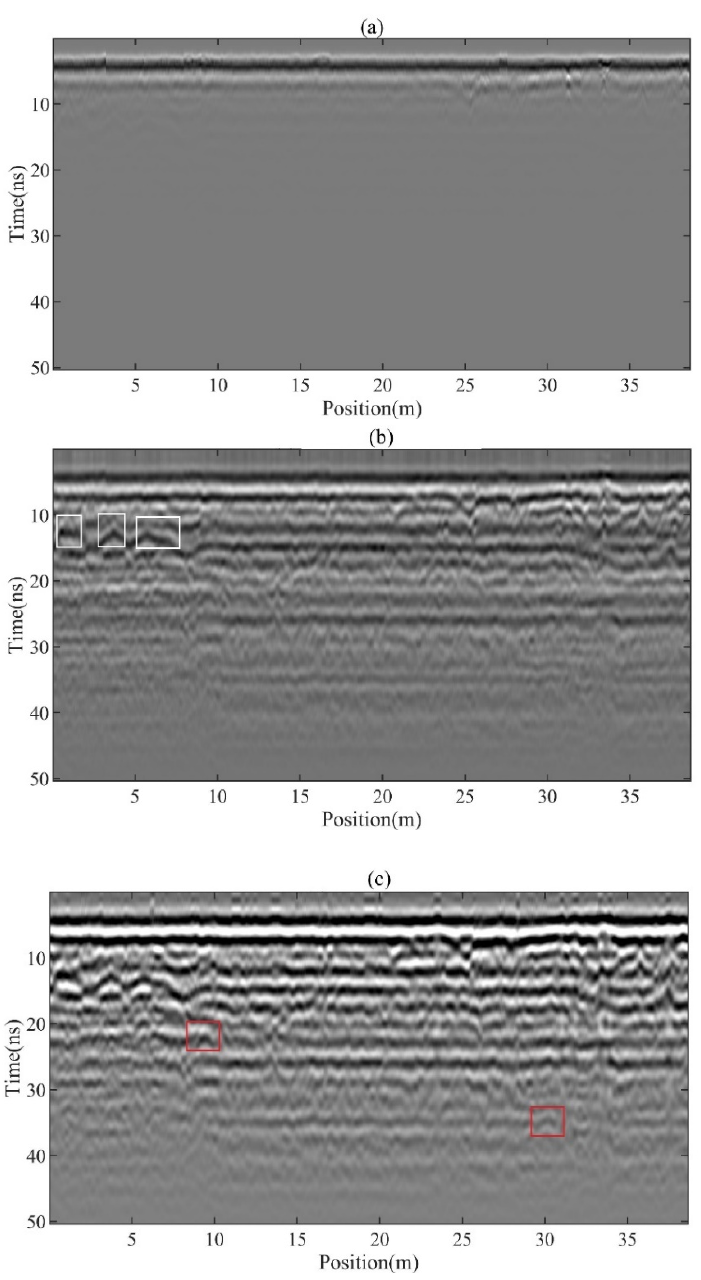
Figure 4. The comparison of GPR profile of different steps: ( a ) raw data, ( b ) after pre ‐ processing, and ( c ) after VMD reconstruction.